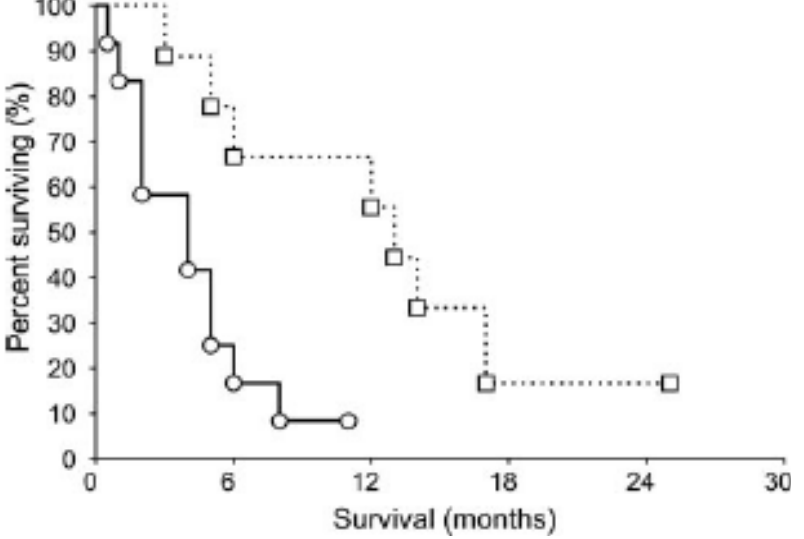
Figure 3. Kaplan-Meier estimate of survival in gemcitabine-treated pancreatic cancer patients. Patients for whom all adenocarcinoma cells had detectable hENT1 (  and dashed line ) had significantly longer survival than those patients with heterogeneous areas of adenocarcinoma cells lacking hENT1 ( ○ and continuous line ; median survival 13 versus four months; P = 0.01). Reproduced with permission from